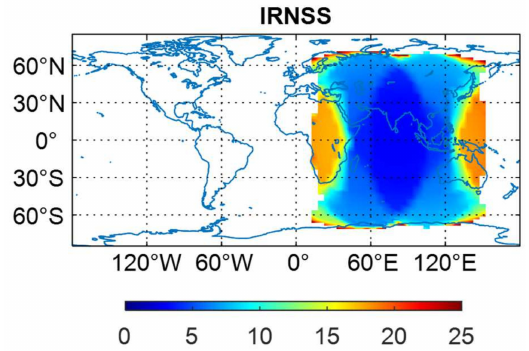
Figure 7. Average value of PDOP for IRNSS-only case.